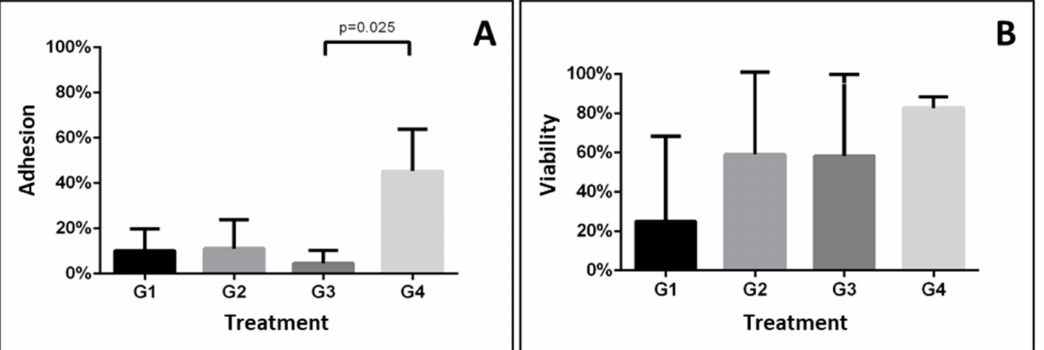
Figure 3. Comparison among the evaluated groups of cell adhesion ( A ) and viability ( B ). Mean ±